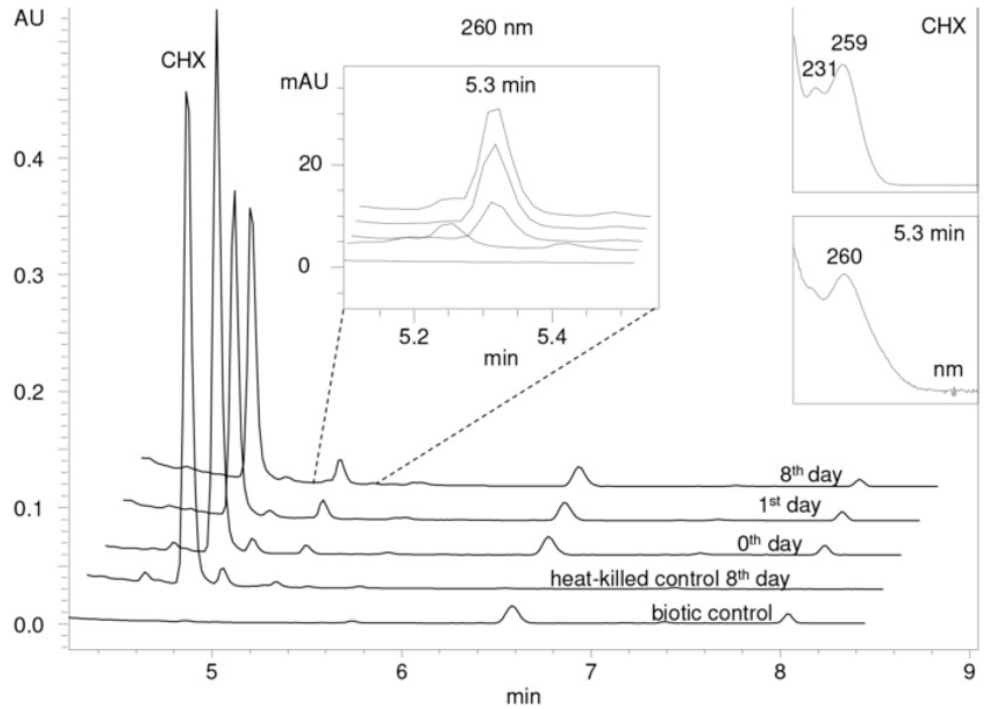
Molecules 2019 , 24 , x FOR PEER REVIEW Figure 4. LC-UV plots of degradation samples acquired during in vitro chlorhexidine (CHX) degradation in the concentrated extracellular liquid of I. lacteus supplemented with Mn 2 + and H 2 O 2 . The UV absorption spectra of specific peaks are given in the insets.